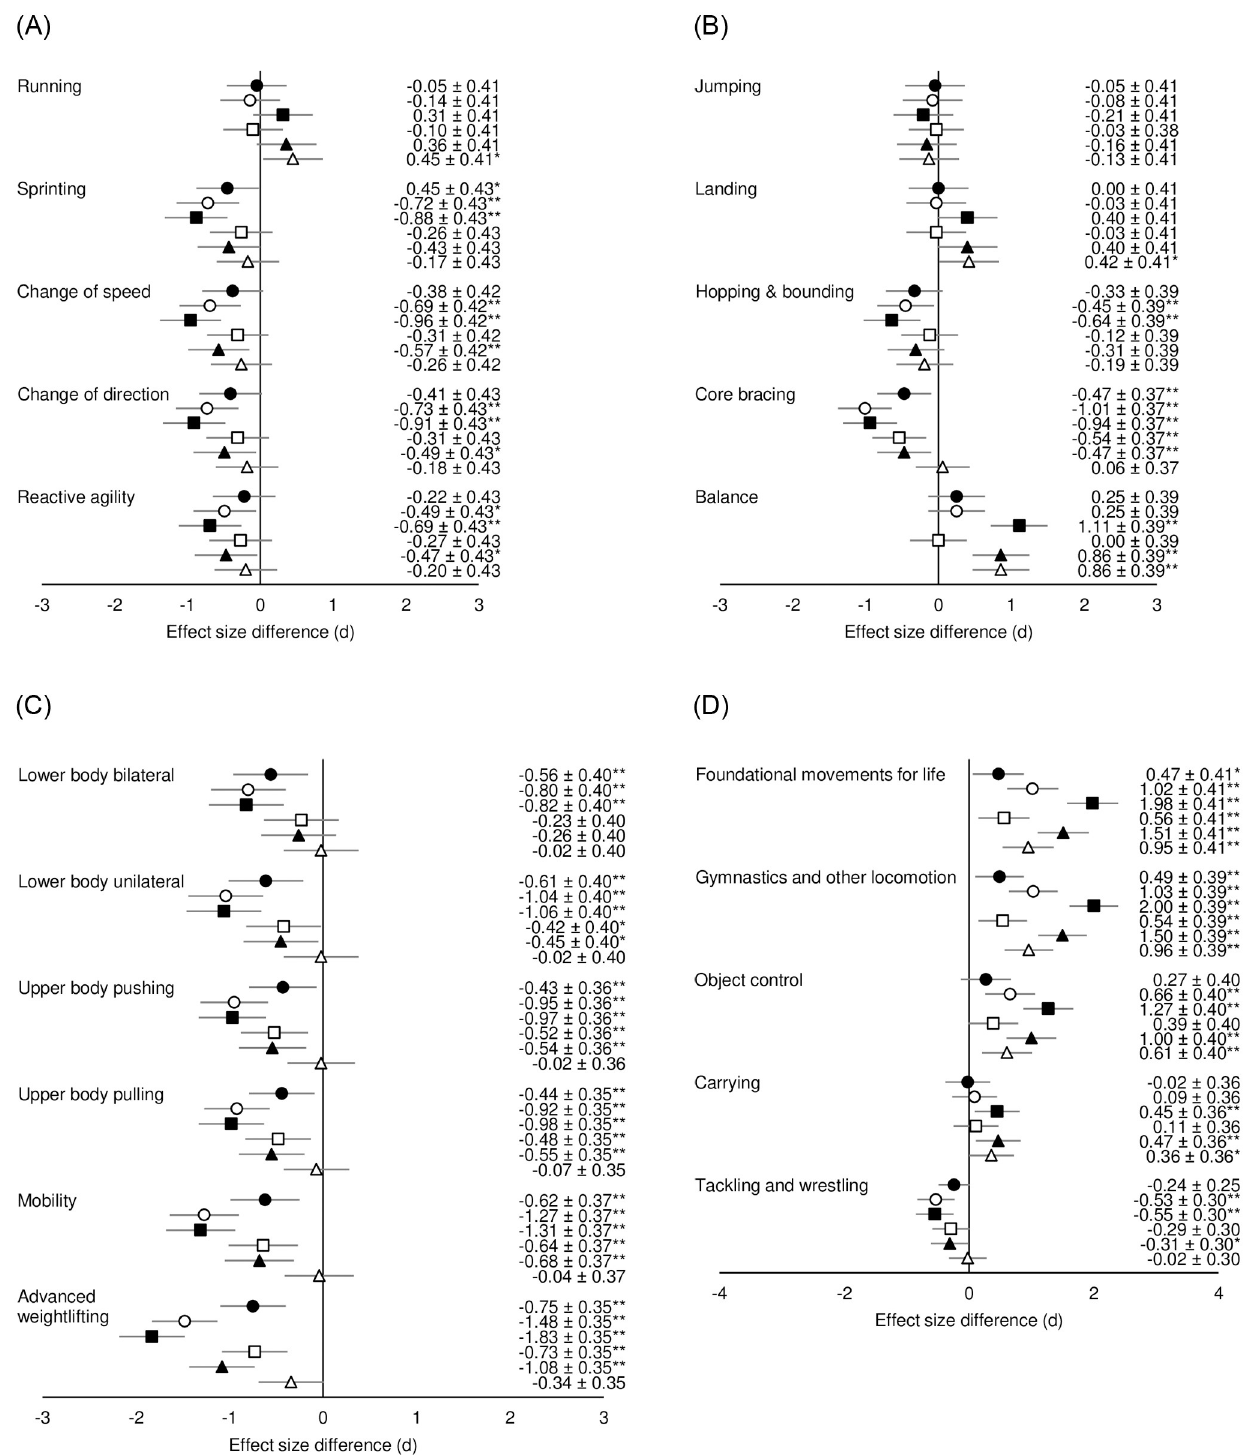
Fig 2. A. Effect size differences in PE teacher’s perceived motor competence importance between stages of maturity for running-based competencies. B. Effect size differences in PE teacher’s perceived motor competence importance between stages of maturity for jumping and stability competencies. C. Effect size differences in PE teacher’s perceived motor competence importance between stages of maturity for strength-based competencies. D. Effect size differences in PE teacher’s perceived motor competence importance between stages of maturity for other fundamental/foundational competencies. Black circles = childhood vs. pre-PHV; white circles = childhood vs. circa-PHV; black squares = childhood vs. post-PHV; white squares = pre- vs. circa-PHV;